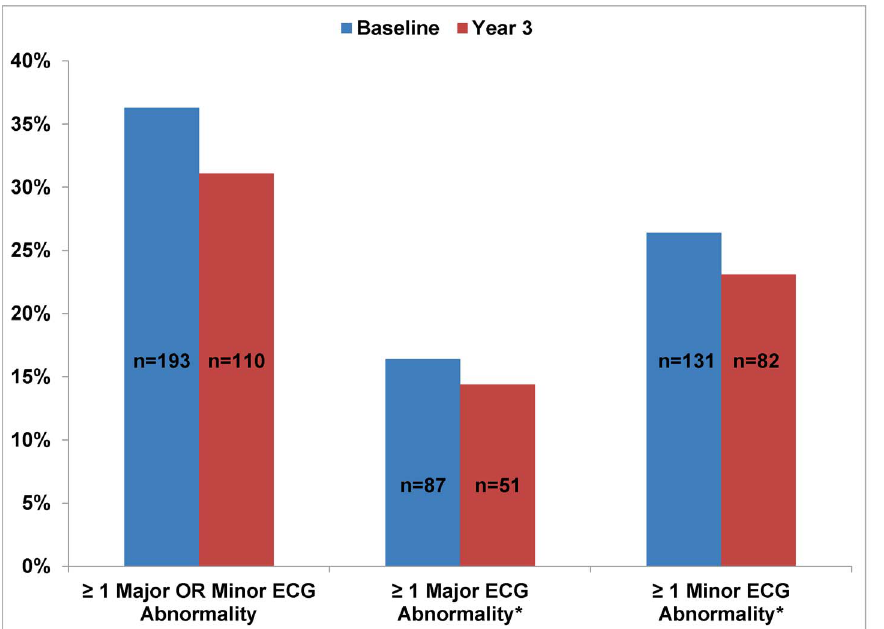
Figure 1. Prevalence of Major and Minor ECG Abnormalities. The percentage of subjects with major and minor ECG abnormalities at baseline (blue) and at year 3 (red). Year 3 percentages include both continued smokers and those who abstained. All p-values for comparisons between baseline and year 3 ECG abnormalities were non-significant ( , 0.05). ECG=electrocardiogram. *Subjects may have had more than one major and/or minor ECG abnormalities. Each abnormality was tallied